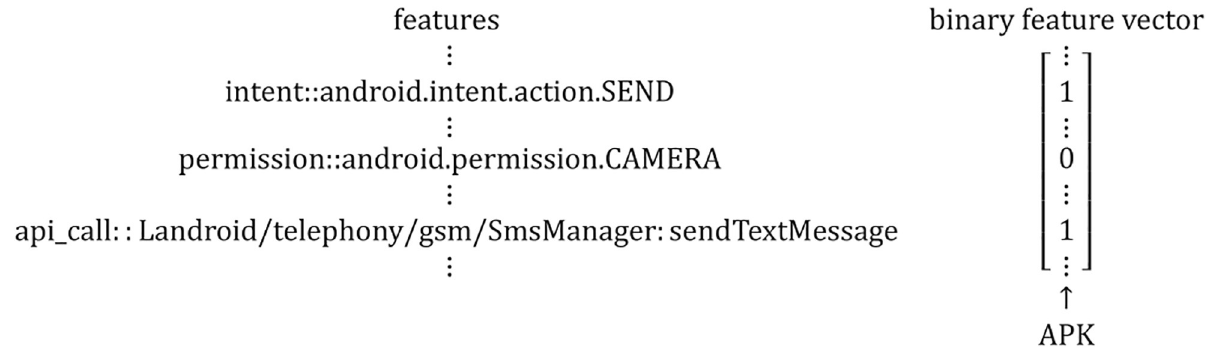
Fig 2. The form of feature